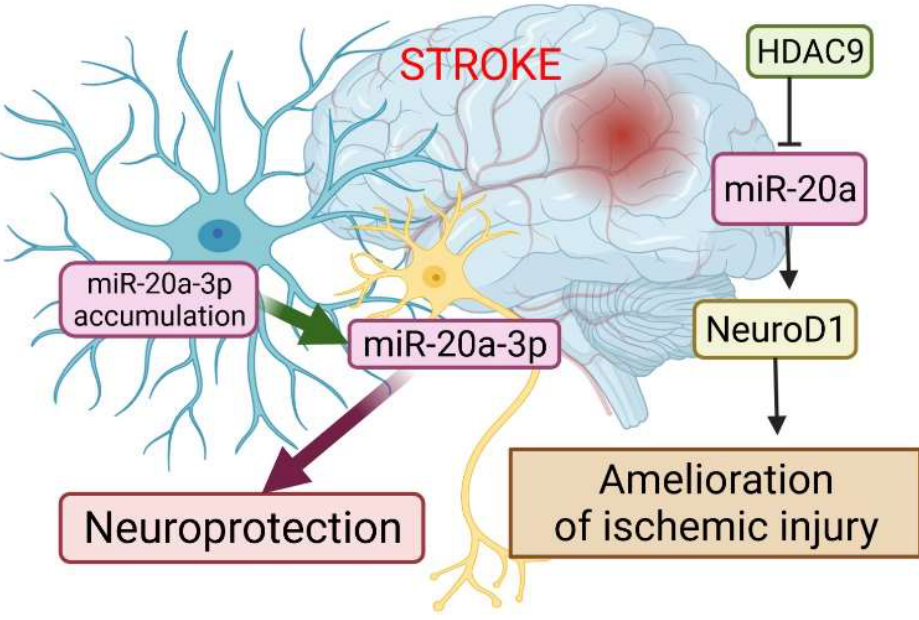
Figure 4. The role of miR-20a in the pathophysiology of stroke. The dysregulation of miR-20a after stroke has a more complex character. Astrocytes are the cells that upregulate miR-20a-3p after stroke; this miRNA is then specifically transferred to neurons or other neural cell types to provide neuroprotection. Another way to alleviate ischemic stroke is to suppress miR-20a by HDAC9 by enriching its promoter, which in turn allows activation of Neuro D1. This image was created using BioRender (accessed on 30 March 2022).